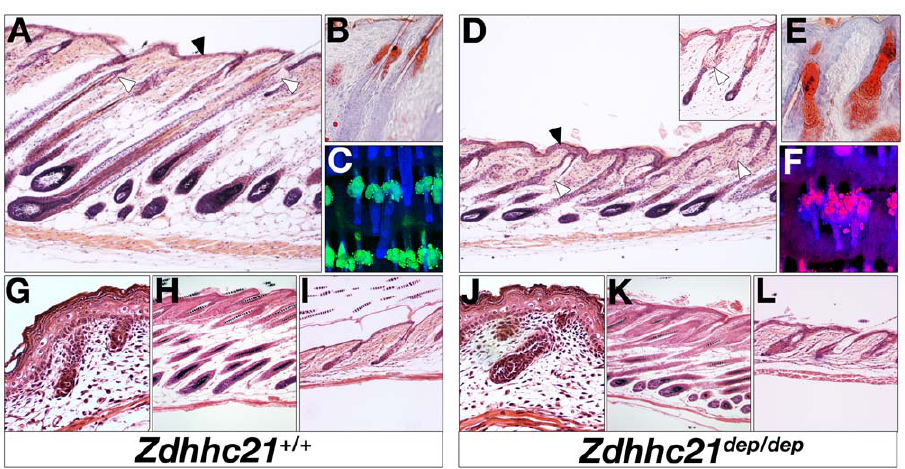
Figure 4. Zdhhc21 is required for epidermal differentiation and patterning. dep mutant skin displays pronounced defects postnatally associated with anagen stages of hair cycle including abnormal hair follicle differentiation, and interfollicular and sebaceous hyperplasia. Stages shown: anagen P28 (A–F), late embryonic morphogenesis E18.5 (G,J), early catagen P14 (H,K) and telogen P21 (I,L). Hematoxylin and eosin staining (A,D,G–L). Oil-Red-O staining of cryosections (B,E). Nile red wholemount staining of P28 tail skin(C,F). Insert in (A) shows histology of a ‘‘hairless’’ dorsal region at P28: note the more severe follicular phenotype. Filled arrowheads mark the interfollicular epidermis and open arrowheads point to examples of sebaceous glands.